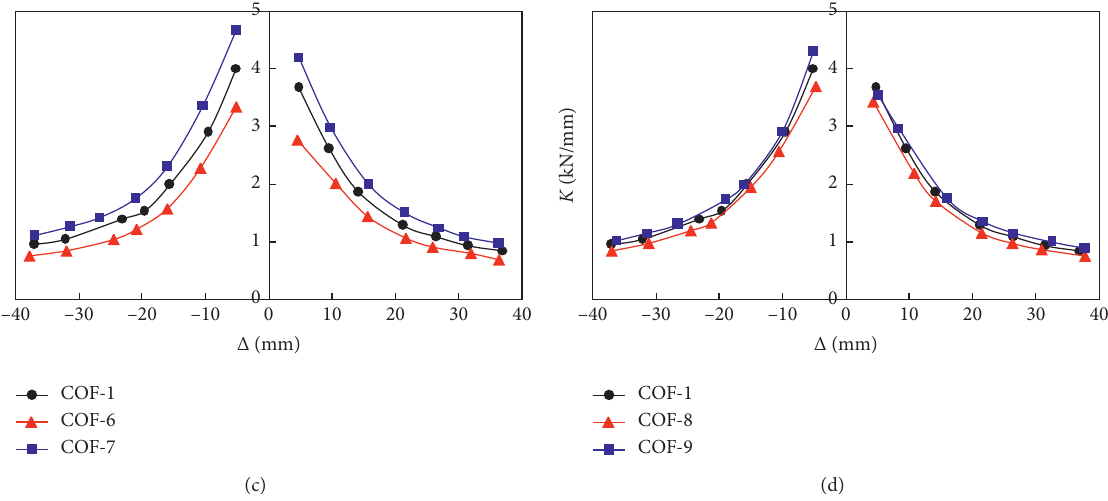
Figure 15: Comparison on stiffness degradation of COF system.